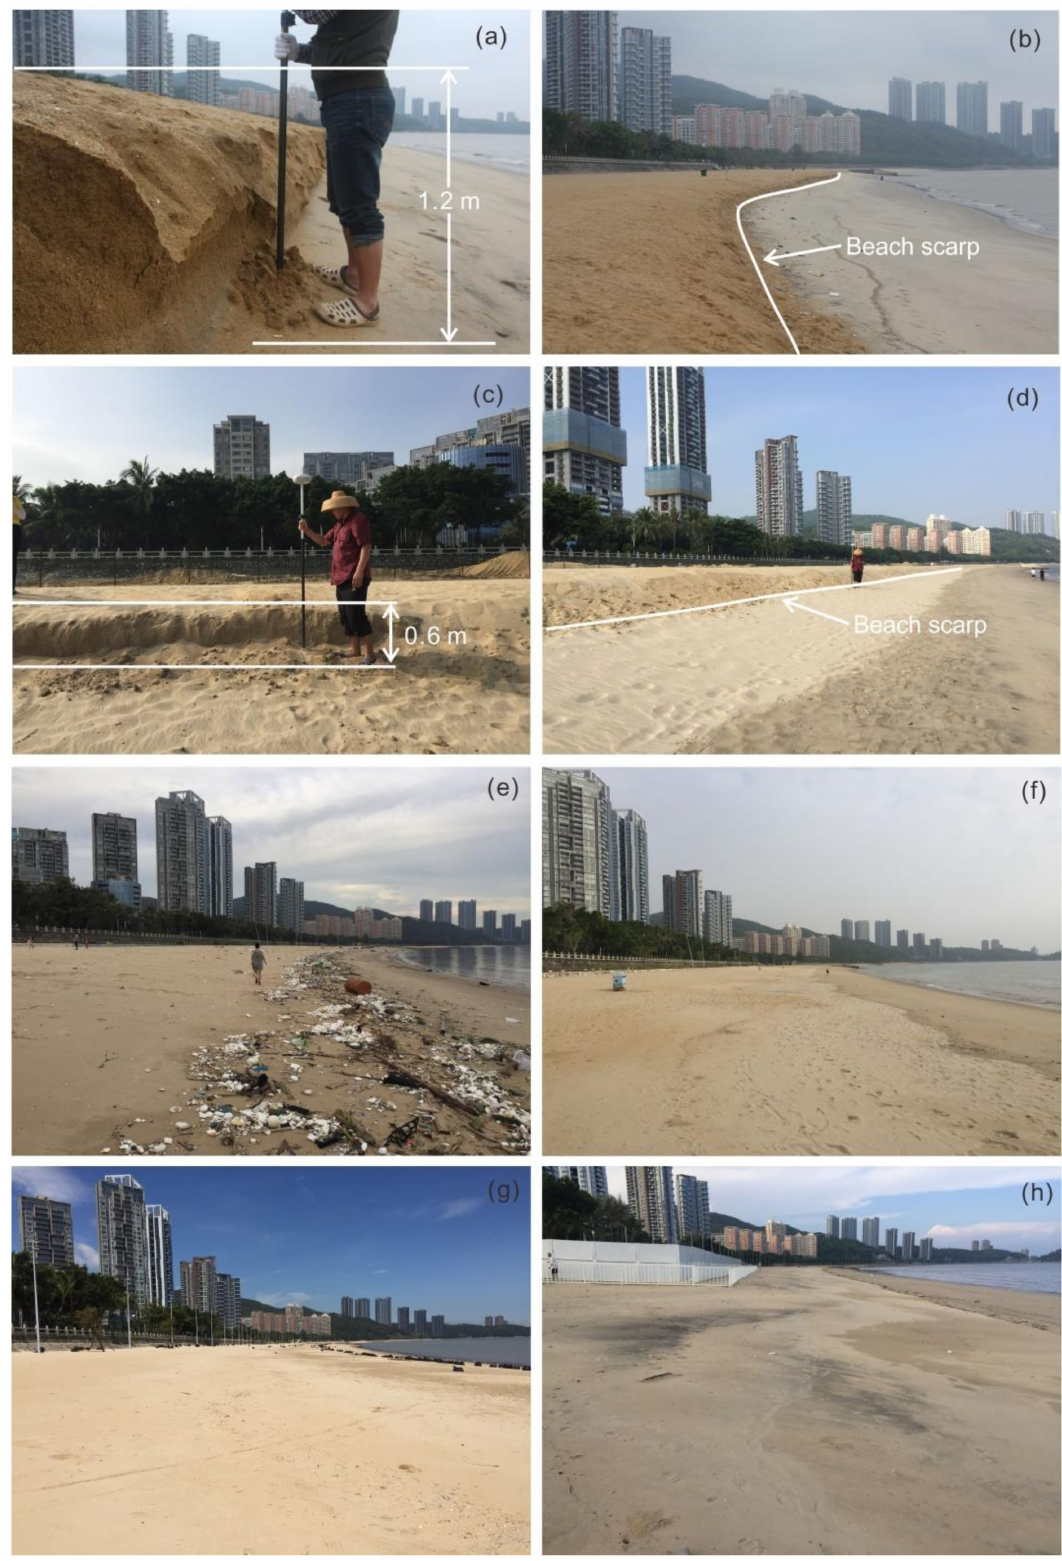
Figure 7. The presence and absence of beach scarp at different periods. March 2016 ( a , b ), November 2016 ( c , d ), August 2017, post-storm Hato ( e ), November 2017 ( f ), September 2018, post-storm Mangkhut ( g ), and August 2020, post-storm Higos ( h